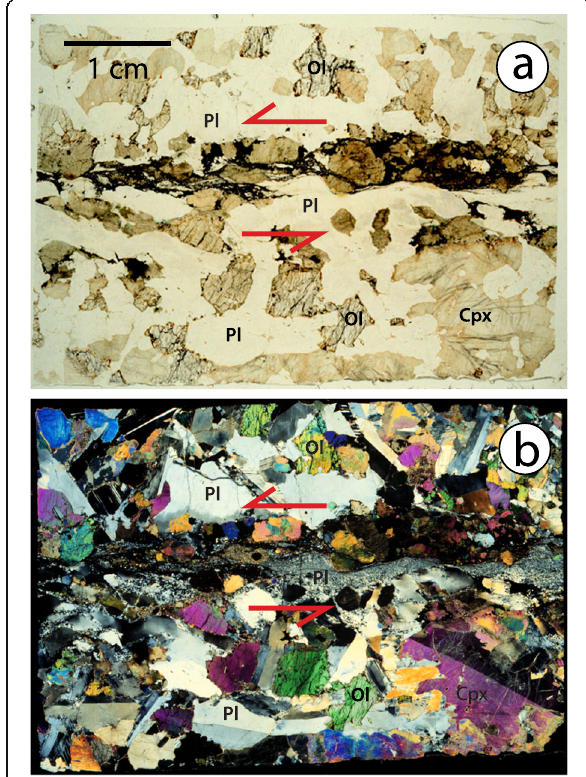
Fig. 16 a Plane and b cross-polarized images of an olivine gabbro thin section crosscut by an oxide gabbro along a crystal-plastic shear zone from Hole 735B (Core 82, Section 3, Piece 1c). Oxide-rich, crystal-plastic shear zone bounded by red slip